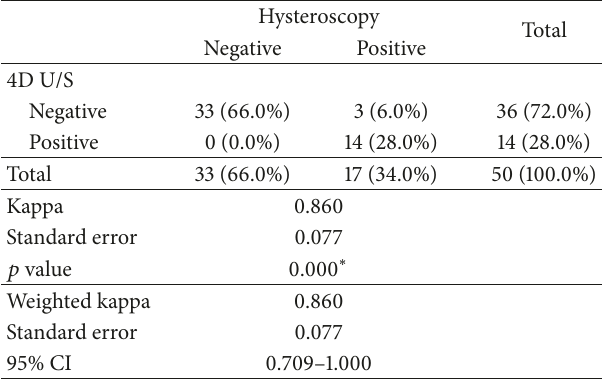
Table 4: Uterine